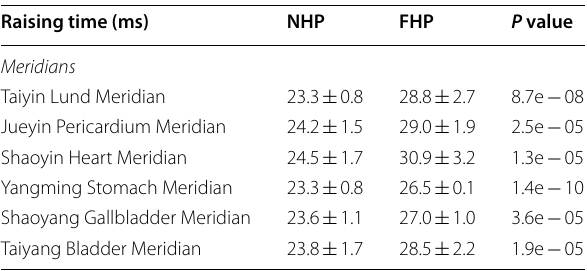
Table 2 The arithmetic means and standard deviation of the τ values of the Sanyang meridian of the hand and rising